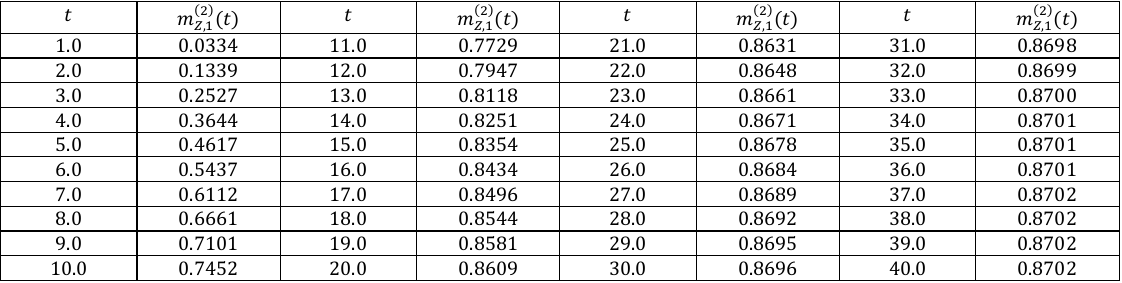
Table 4. Environment level 1 dependent growth of maligant cells (Two